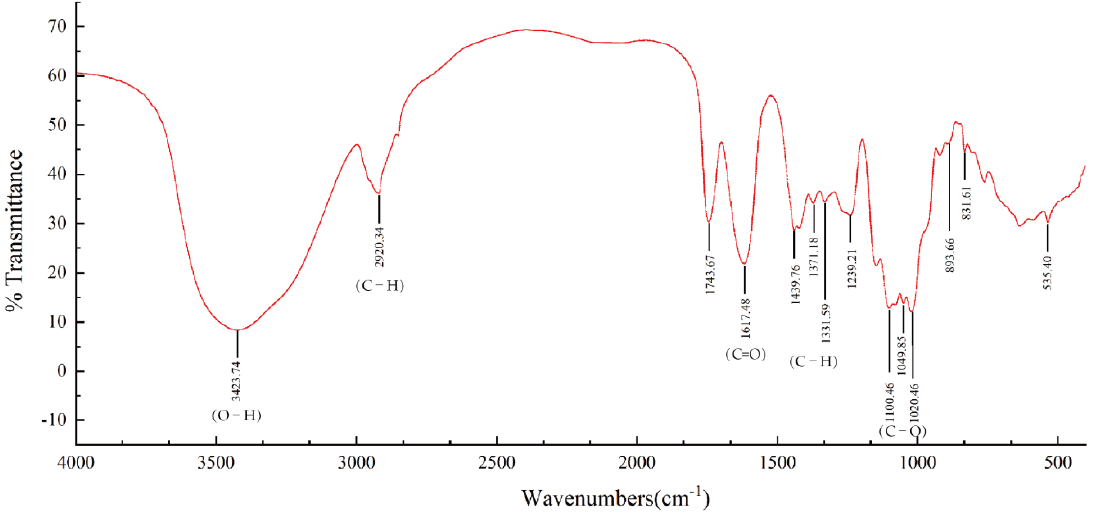
Figure 5. FT-IR spectrum of